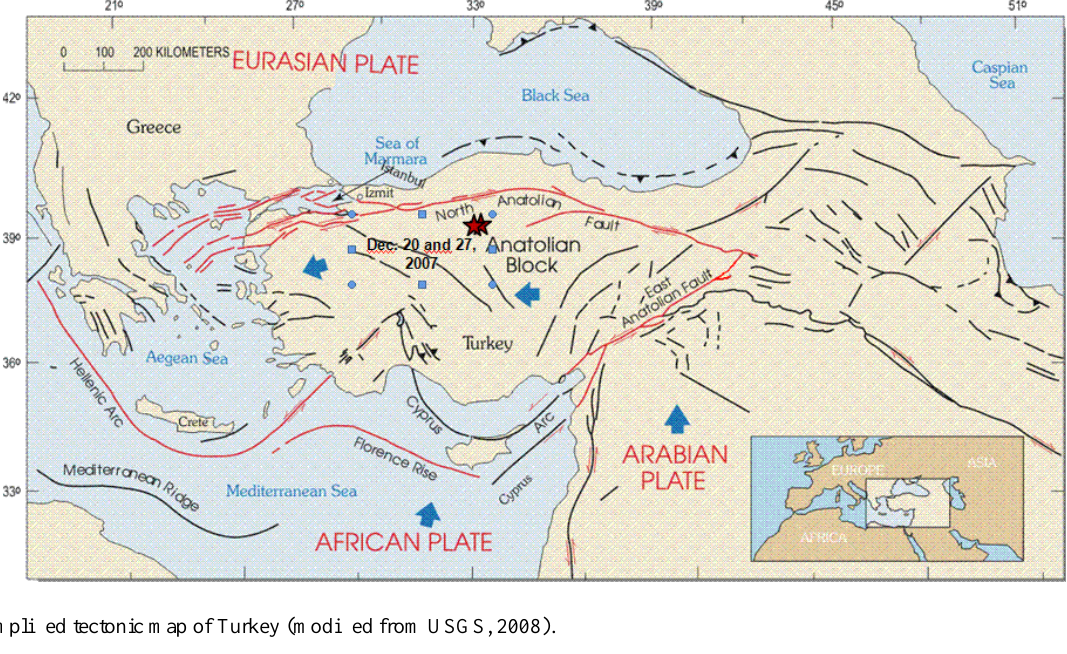
Fig. 1 Simplified tectonic map of Turkey (modified from USGS 2008)